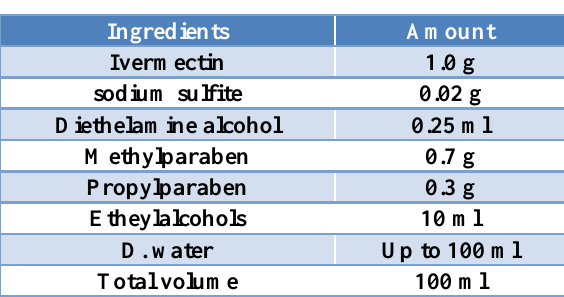
Table, 2: Ingredients of formula for 100 ml